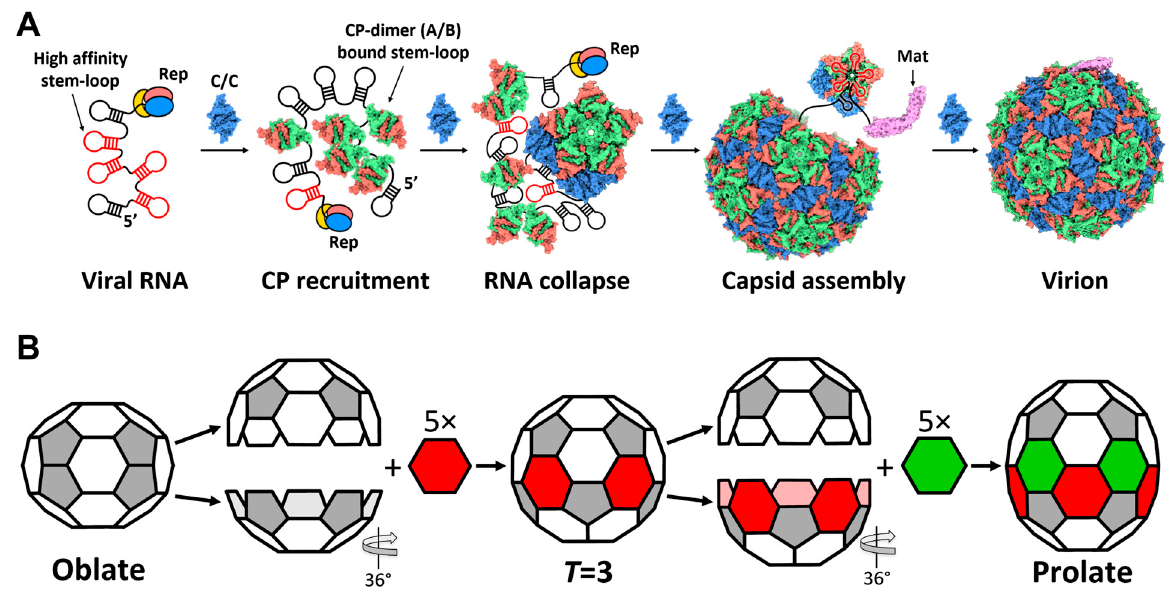
Figure 5. Proposed model for the co-replicational assembly of the Q β virion, and the geometrical relationship between the oblate, T = 3, and prolate VLPs. ( A ) Proposed model for assembly of the Q β virion along with the gRNA replication. The gRNA synthesized by the replicase (Rep) presents several high-affinity stem-loops for CP dimers, which, upon binding to CP dimers, change their conformations from C/C to A/B. The protein–protein interactions of CP dimers on the growing capsid facilitate RNA collapse, and form the first pentamer, then other pentamers and hexamers. Almost towards the end of the assembly (after the last stem-loop, U1, has been synthesized), the Mat binds to the 3 (cid:48) UTR, and is incorporated into the capsid to form a complete virion. ( B ) The geometrical relationship between the oblate, T = 3, and prolate VLPs. The conversion from the oblate to T = 3 VLPs can be achieved through the division of the oblate VLP, perpendicular to the 5-fold axis, into two hemispheres, with one hemisphere rotated 36 ◦ relative to the other, followed by the insertion of five hexamers (red). The elongation from the T = 3 to prolate VLP follows the same protocol with an addition of five more hexamers (green).